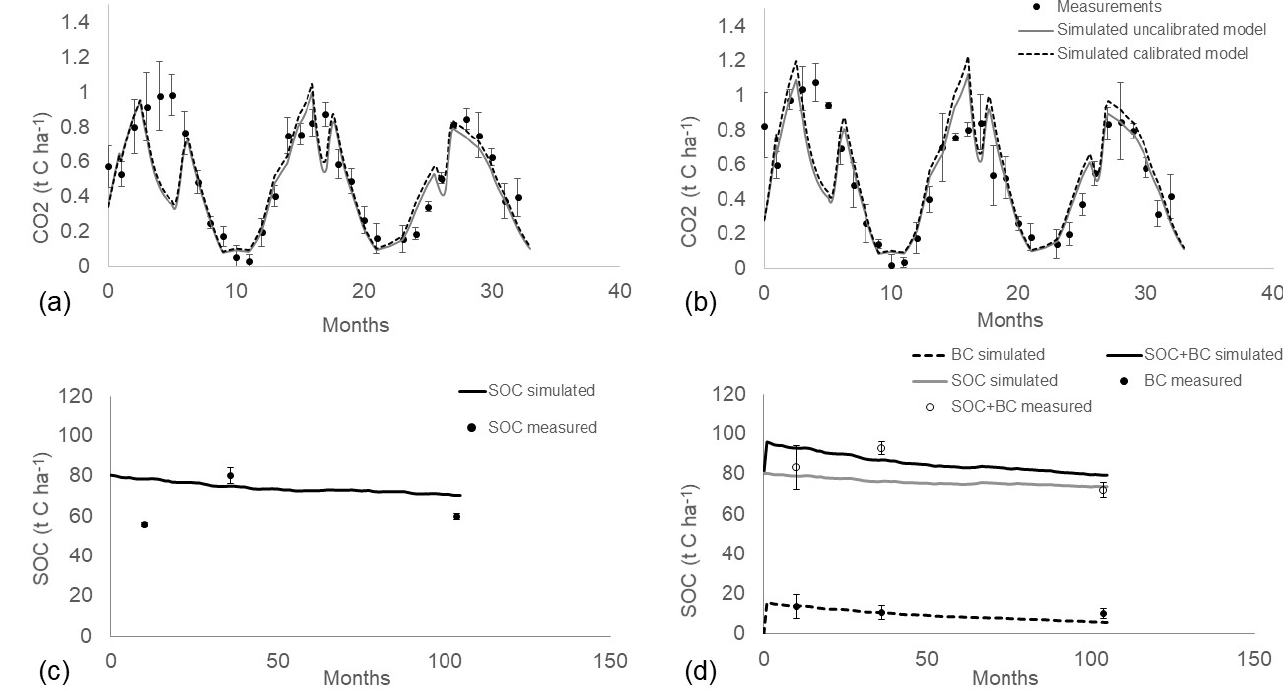
Figure 2. (a) Measured (circles) and simulated (lines) heterotrophic respiration, according to the control model before calibration (solid lines) and after calibration (dashed lines), across a 3-year period (2012–2014). (b) Measured (circles) and simulated heterotrophic respiration, according to the biochar model, before calibration (solid lines) and after calibration (dashed lines), across a 3-year period (2012–2014). (c) Calibration (dashed line) and validation (solid line) of control model against SOC measurements (circles) taken in 2013, 2015 and 2020. (d) Measured (unfilled circles), simulated SOC (solid grey line) and SOC with biochar C (solid black line) in model validation. Biochar C (filled circle) and simulated biochar C (dashed line) represent the amount of biochar in soil without native SOC. Month of simulation 0 corresponds to March 2012, and month of simulation 105 corresponds to December